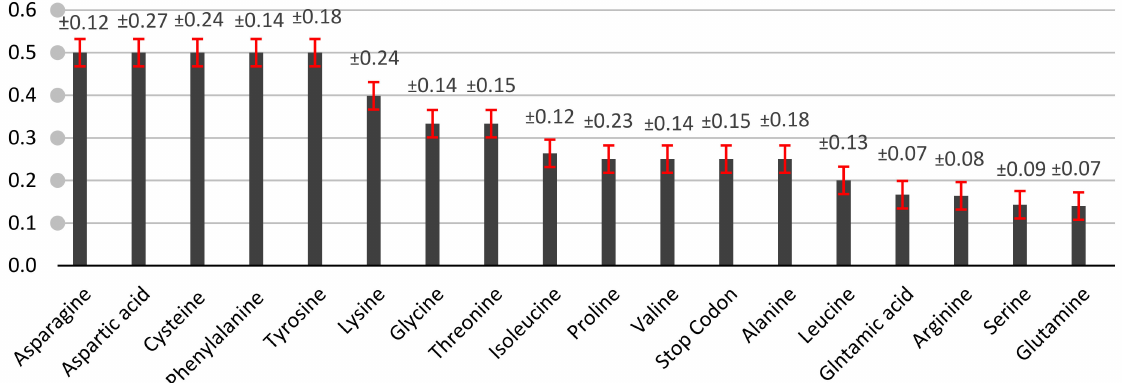
Figure 1. The RSCU mean in heat shock protein sequences based on mRNA for the Solanum lycoper- sicum cultivar Heinz 1706, excluding Methionine and Tryptophan, with standard error shown by the red line and label with standard deviation ( ±